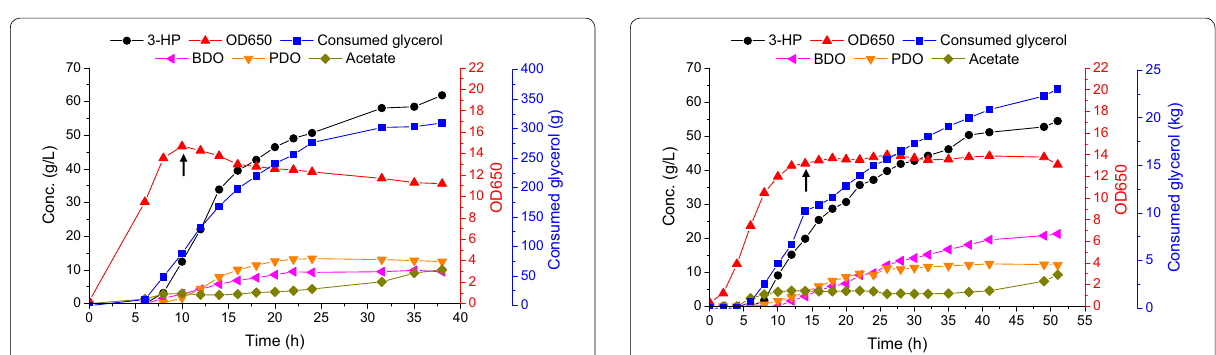
Fig. 4 The profiles of cell density, 3-HP and other metabolites by strain JJQ02(pUC18- kan - aldH ) in a 300-L bioreactor. OD 650 (back up-pointing triangle); 3-HP (black circle); PDO: 1,3-propanediol (back down-pointing triangle); BDO: 2,3-butanediol (back left-pointing triangle); acetate (black diamond); the black arrow represents the time point to lower the aeration